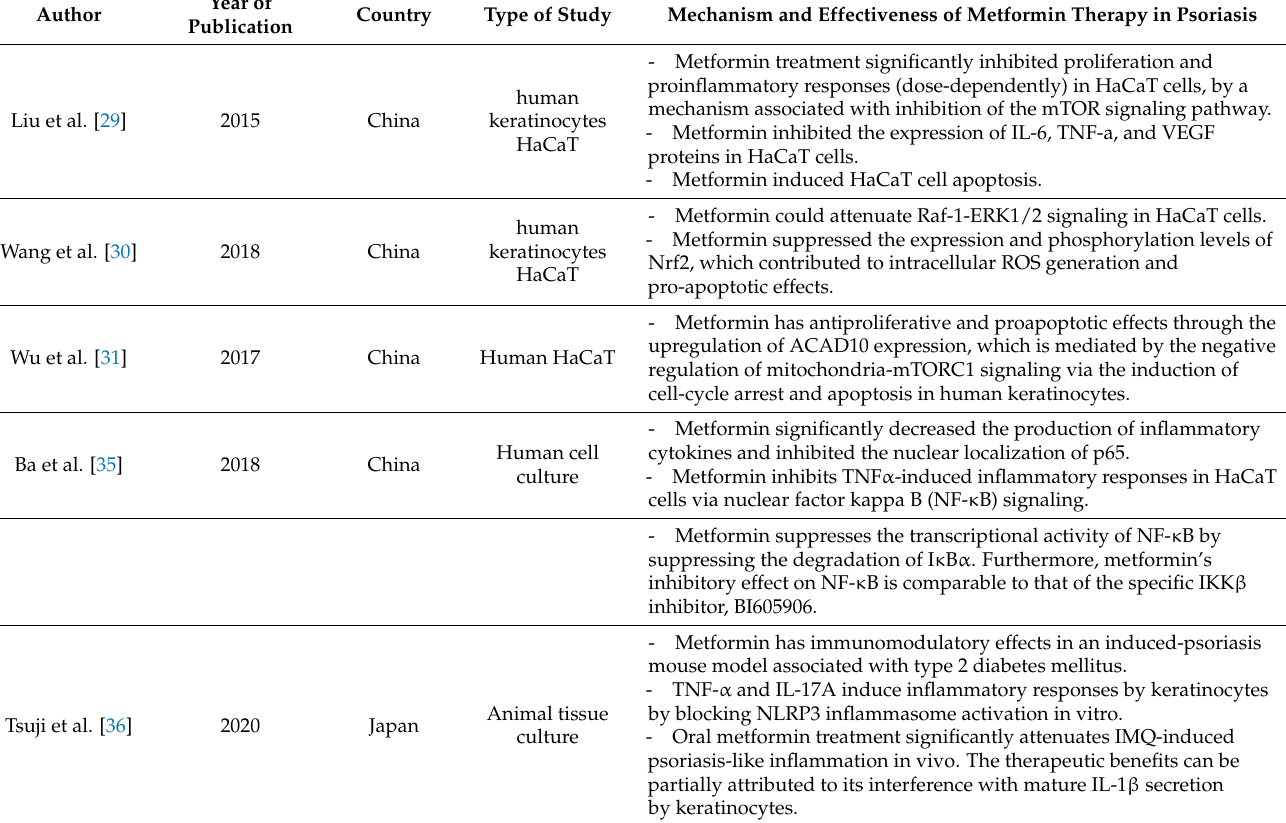
Table 1. Skin culture studies included in the